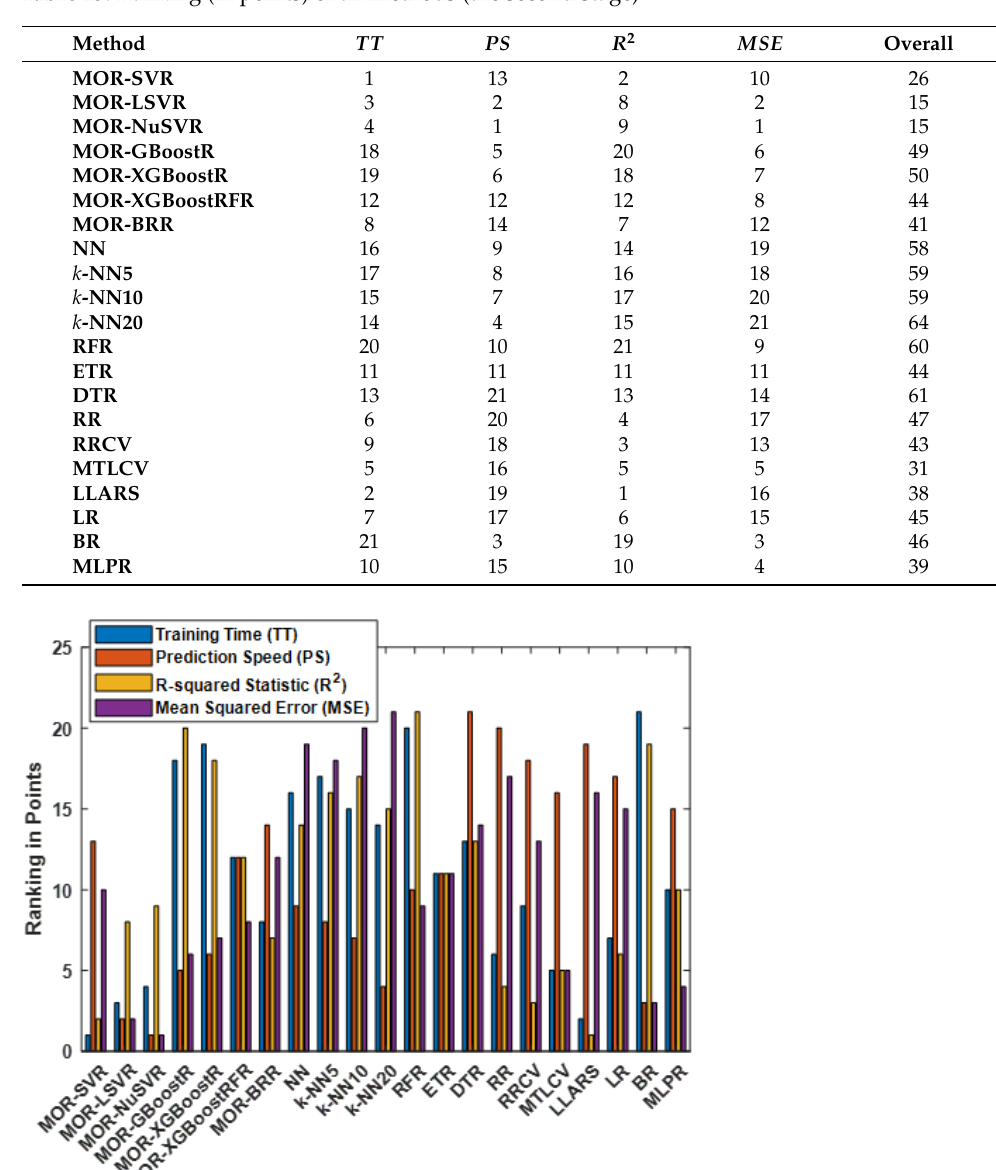
Table 13. Ranking (in points) of all methods (the second stage).